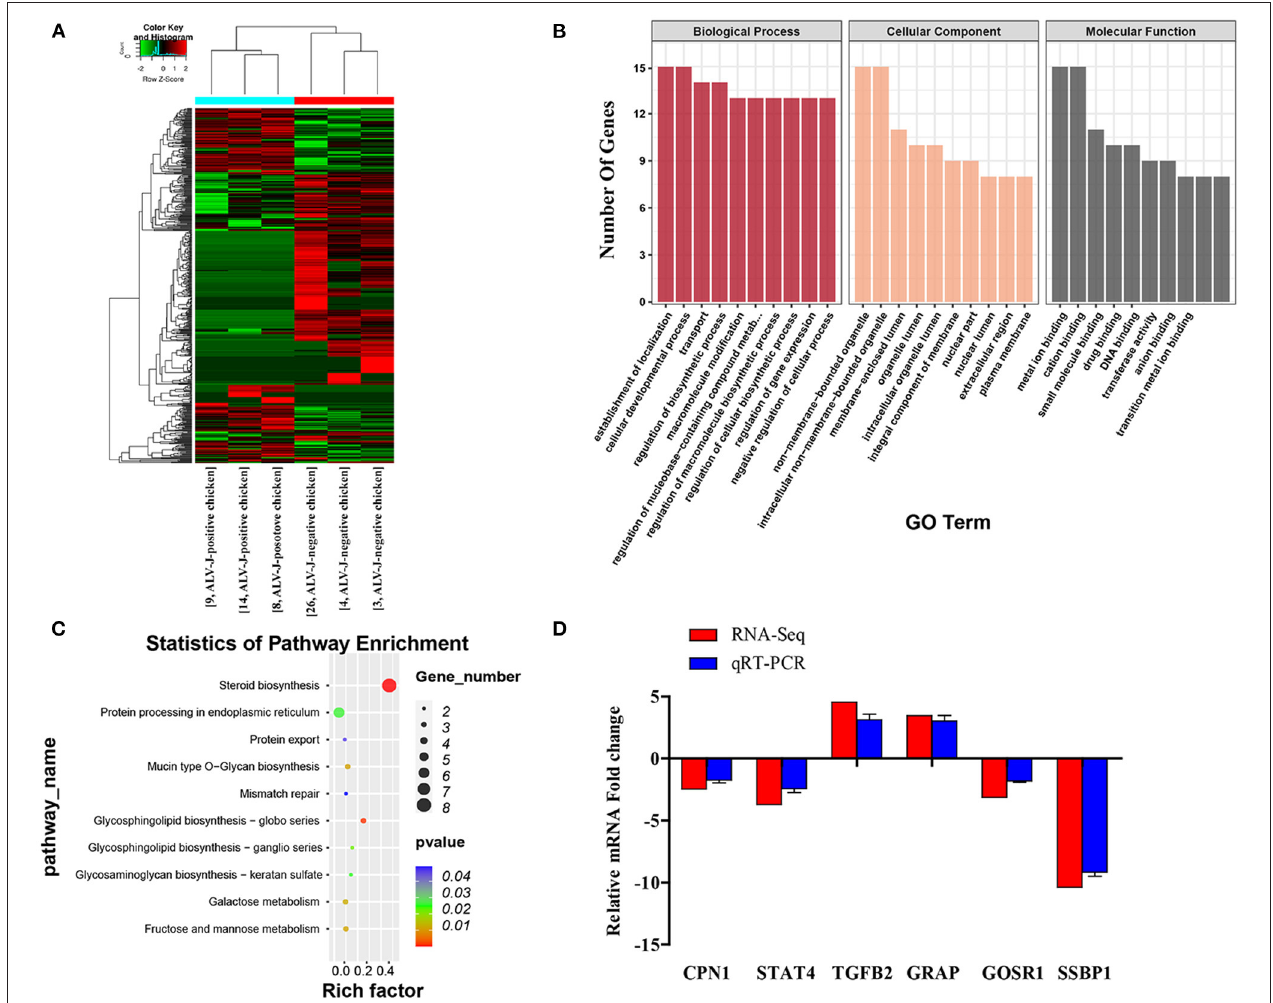
FIGURE 7 | General profiling of the differentially expressed genes (DEGs). (A) Heatmap of DEGs from RNA-seq profiles; (B) the significant GO categories of the DEGs; (C) pathway analysis of the DEGs; (D) validation of differentially expressed genes by qRT-PCR. The vertical axis represents fold change of the RNA-seq and qRT-PCR in the ALV-J-positive chickens as compared with the ALV-J-negative